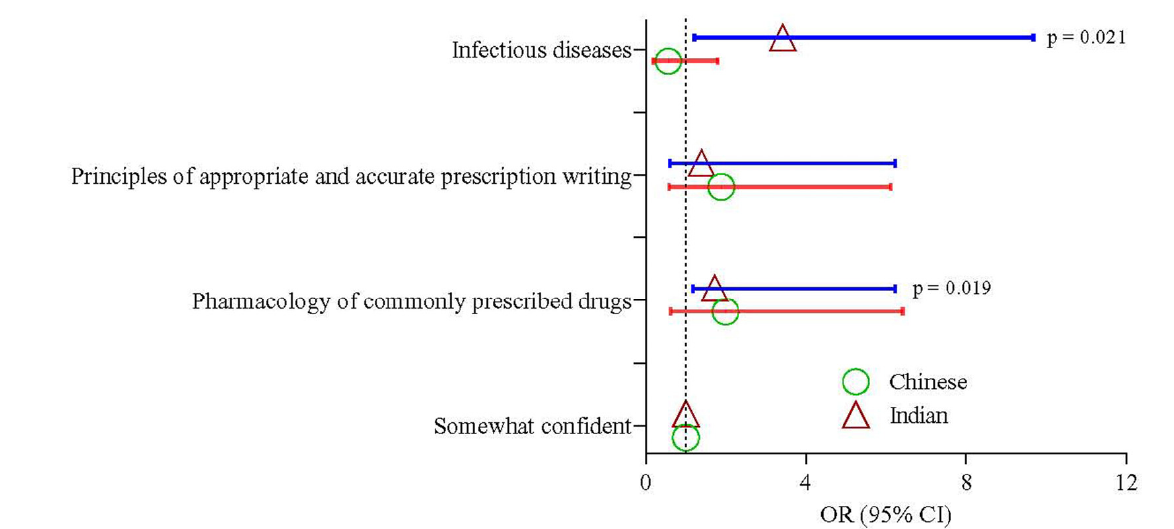
Figure 4. Odds of confidence in knowledge among the Chinese and Indian students compared to the Malay students. Triangle and circle represent the estimates of odds ratios of Indian and Chinese student,